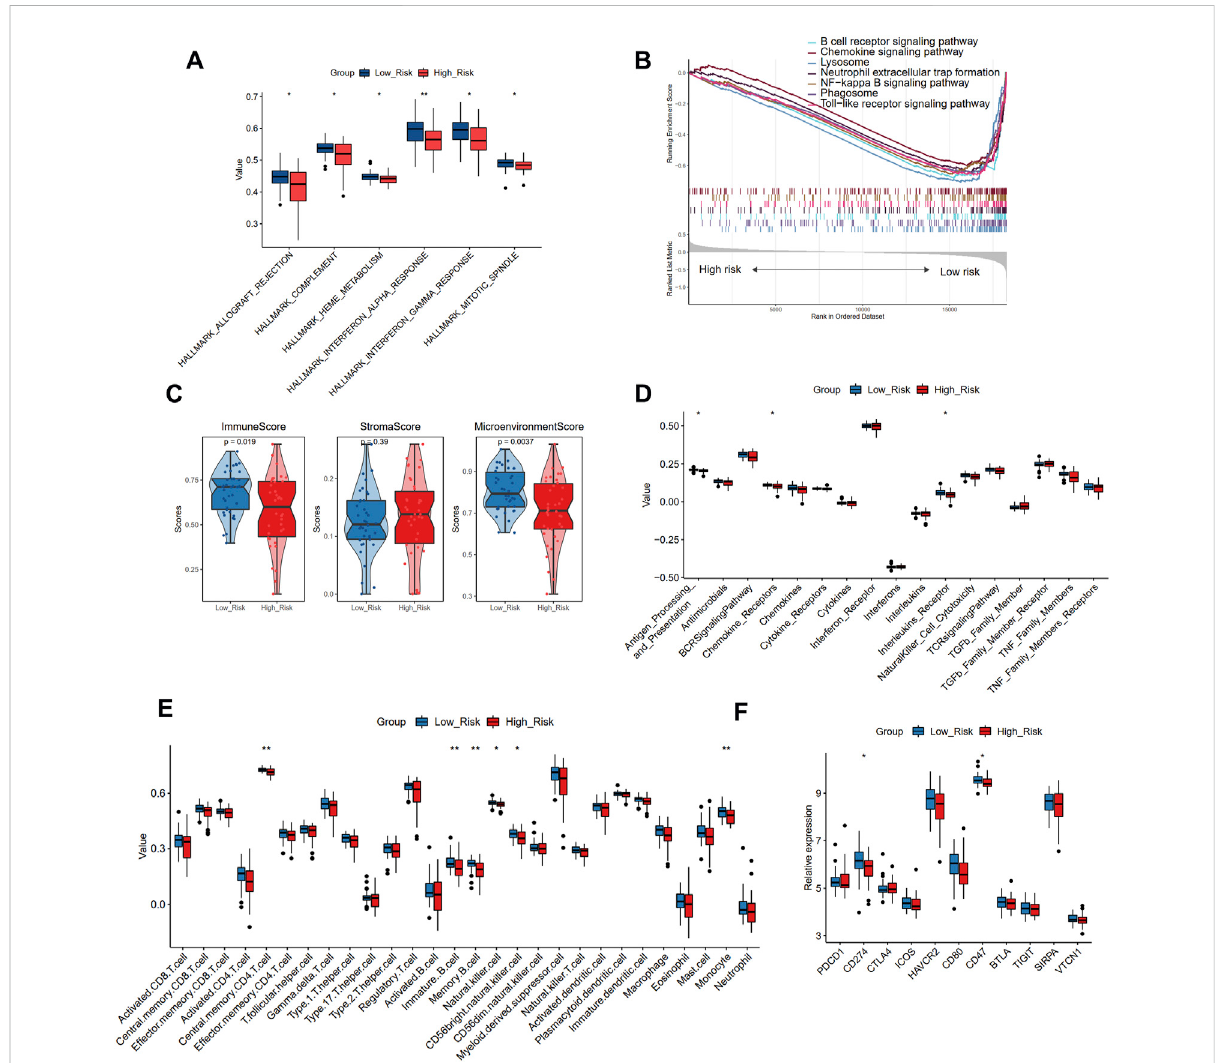
FIGURE 8 The different biological pathways and immune microenvironment between high- and low-risk groups. (A) The signi fi cant different hallmark pathways in two groups with GSVA analysis. (B) The enrichment of KEGG pathways in two groups with GSEA analysis. (C) The comparison of the immune score, stromal score, and microenvironment score in two groups with xCell analysis. (D) The comparison of 17 immune responses in two groups with ssGSEA analysis. (E) The comparison of 28 immune cells in two groups with ssGSEA analysis. (F) The expression levels of immune checkpoint genes in two risk groups. Signi fi cance level was denoted by * p value < 0.05, ** p value < 0.01, *** p value <